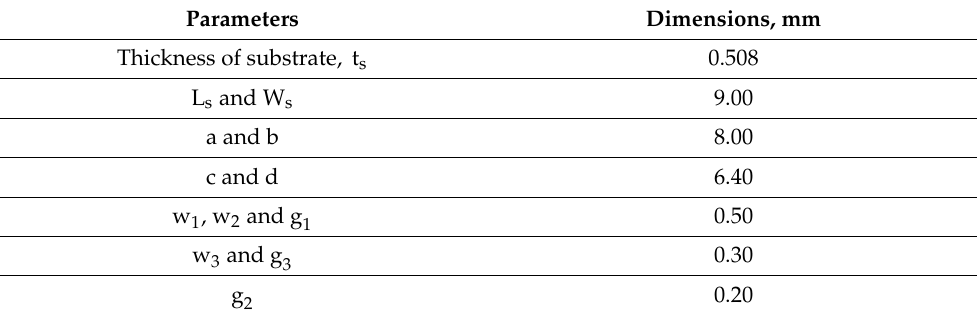
Figure 1. Unit cell metamaterial design, ( a ) perspective view and ( b ) top view of unit cell metamaterial design in CST Microwave Studio. Table 1. Parameters of the oval-square-shaped split-ring resonator-based metamaterial.